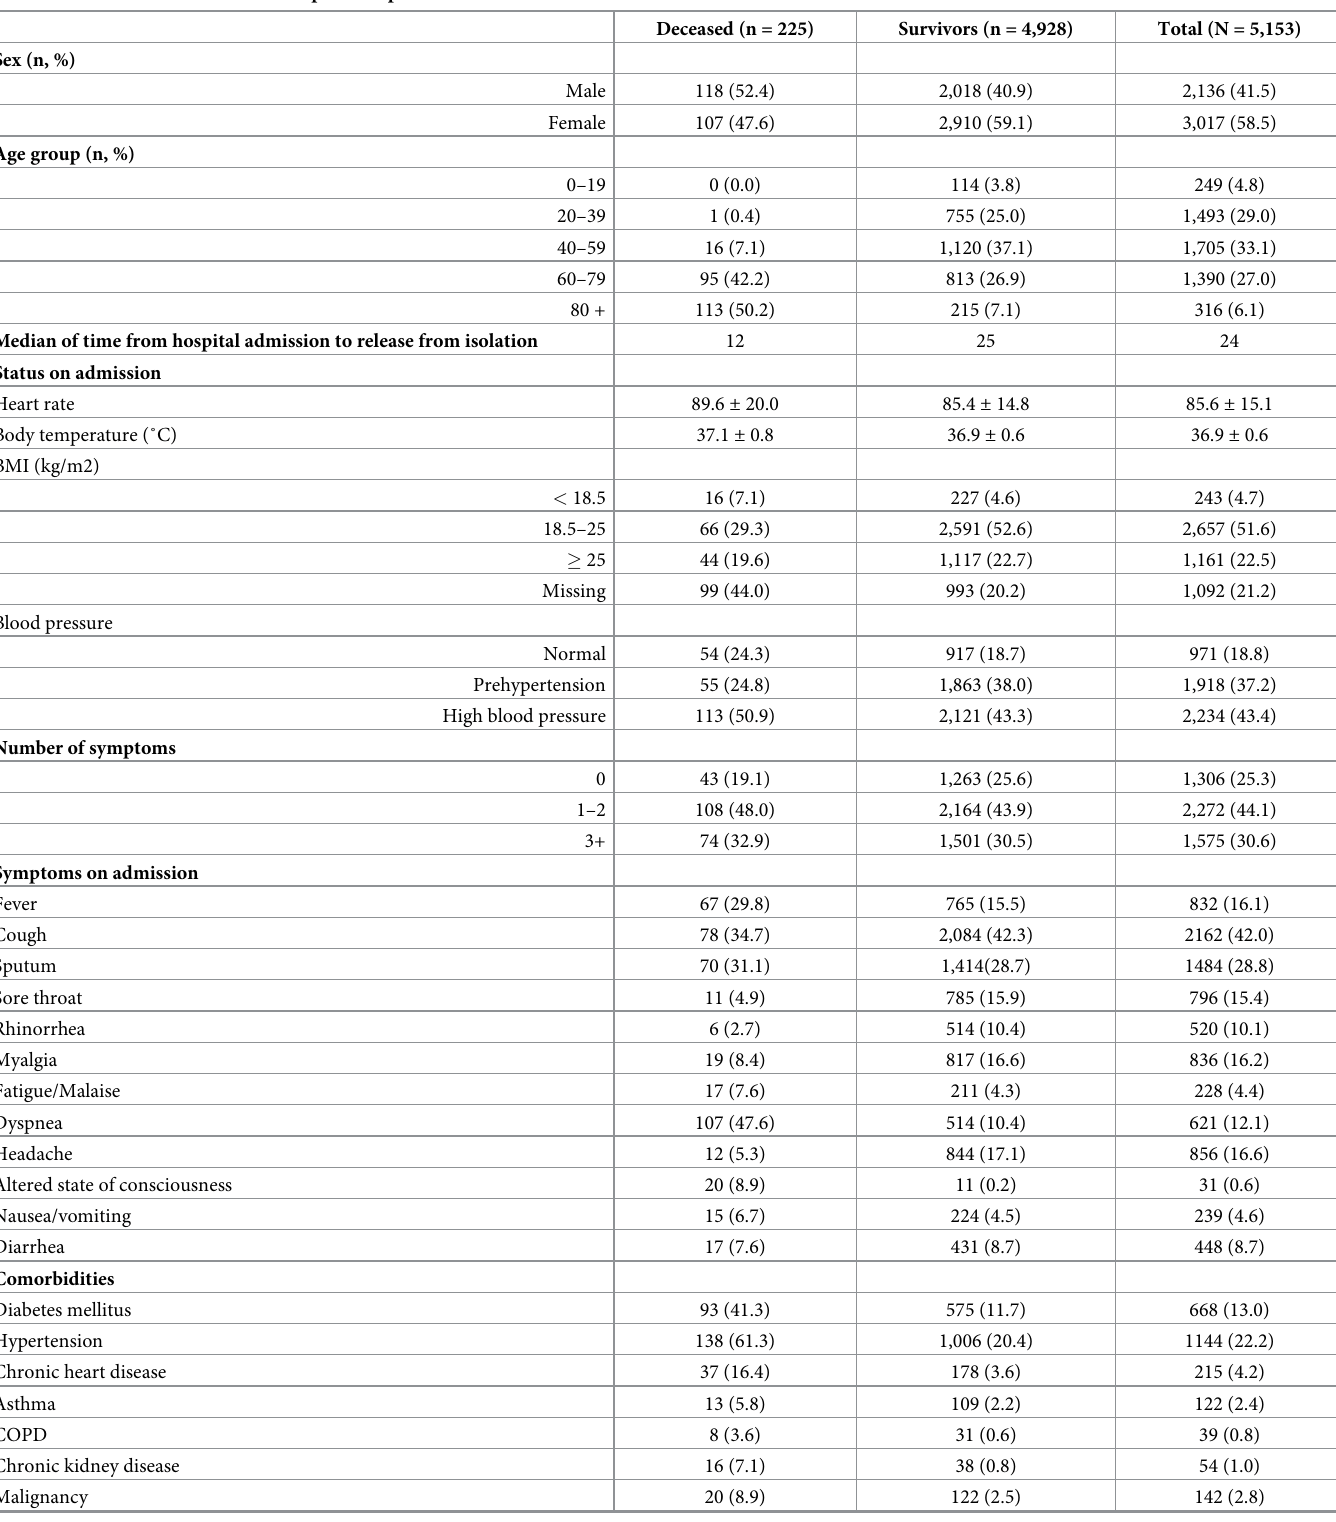
Table 1. General characteristics of hospitalized patients with